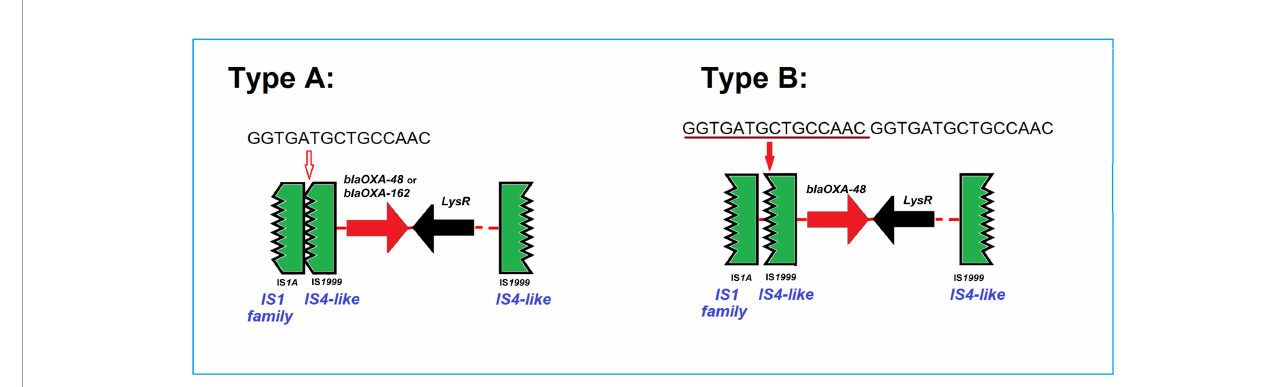
FIGURE 4 | Two types of the genetic surroundings of the bla OXA-48 and bla OXA-162 . Type A and B differ only in the presence or absence of a repetitive 15bp sequence (GGTGATGCTGCCAAC). Type A was detected in 9 bla OXA-48 or bla OXA-162 -encoding IncL/M( pOXA-48 ) plasmids from 8 C . freundii isolates, i.e. Survcare050, Survcare150, Survcare247, Survcare311, Survcare315, Survcare316, Survcare396 and Survcare410 and one C. braakii Survcare336, as well as in the non-IncL/M( pOXA-48 )-bearing Survcare252, which harbored a bla OXA-48 gene. Type B was present in four bla OXA-48 -harboring isolates, whereas two isolates (Survcare163 and Survcare314) were associated with the IncL/M( pOXA-48 ) plasmid and two (Survcare162 and NRZ-45233) were not.